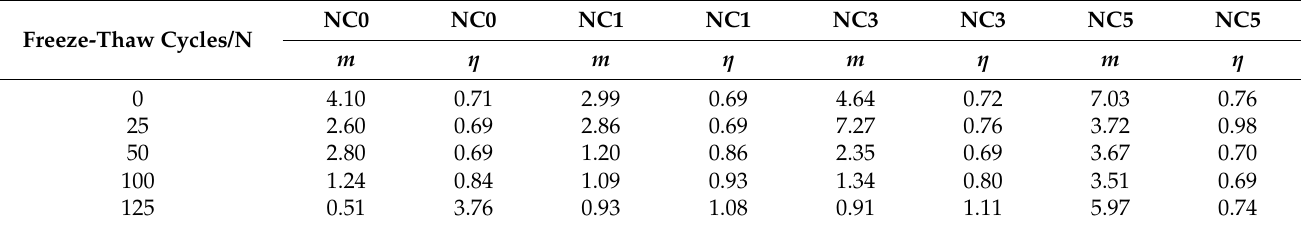
Table 6. Constitutive model parameters of NMK concrete under freeze-thaw